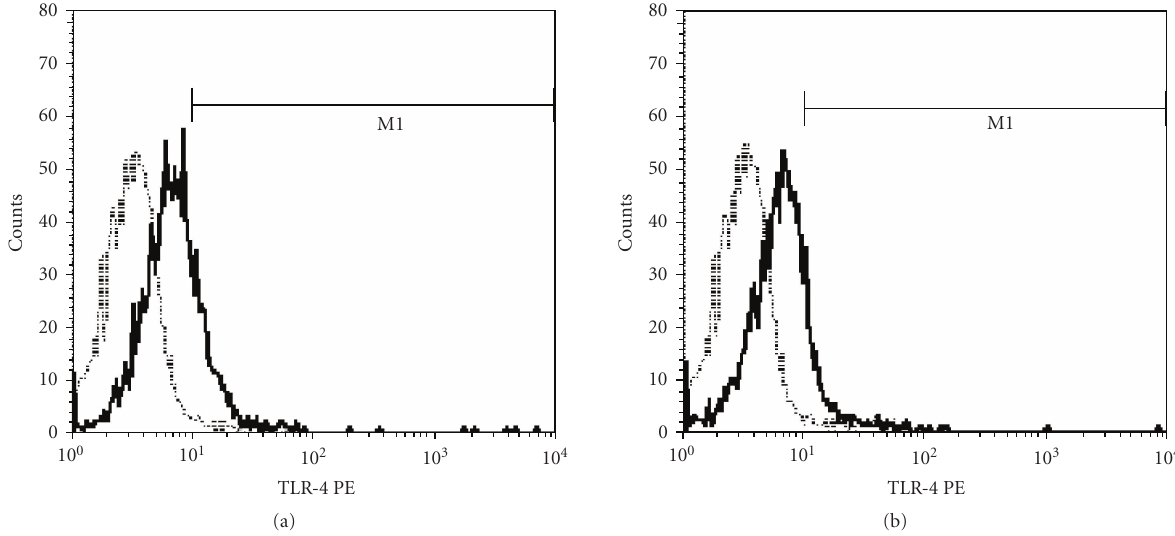
Figure 2: Representative FACS plots of TLR4 staining on PBMC. (a) SIRS; (b) non-SIRS. The non-specific binding is relatively small relative to specific binding as defined by the isotype controls. Dotted line represents the isotype